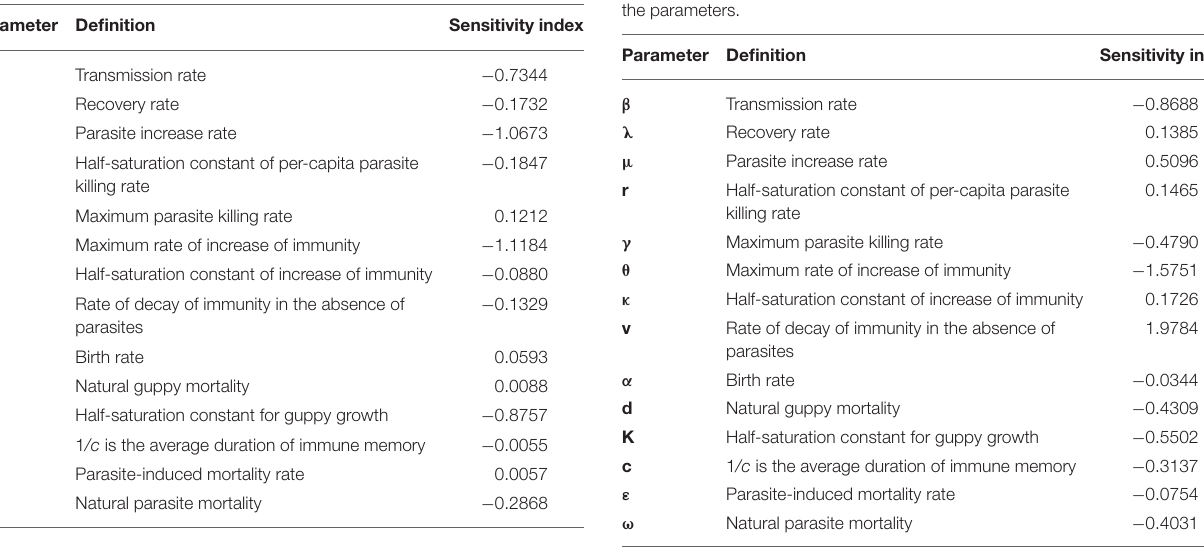
TABLE 3 | The sensitivity of the time to the initial outbreak to the parameters.